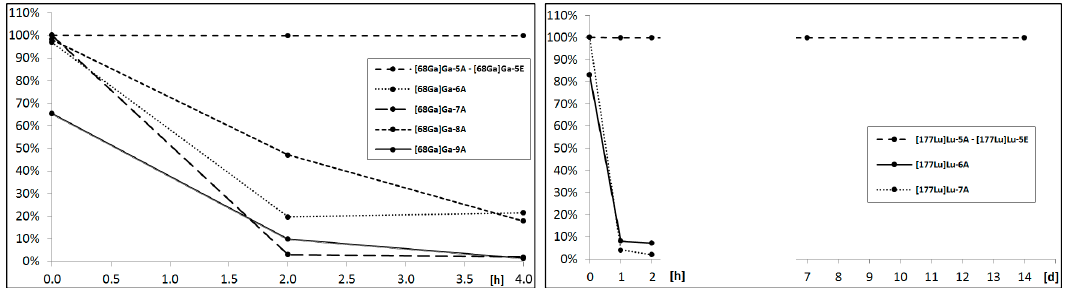
Figure 4. Percentage of intact [ 68 Ga]Ga ‐ radioconjugates ( left ) and [ 177 Lu]Lu ‐ radioconjugates ( right ) determined at specific time points during incubation in 37 °C human serum.